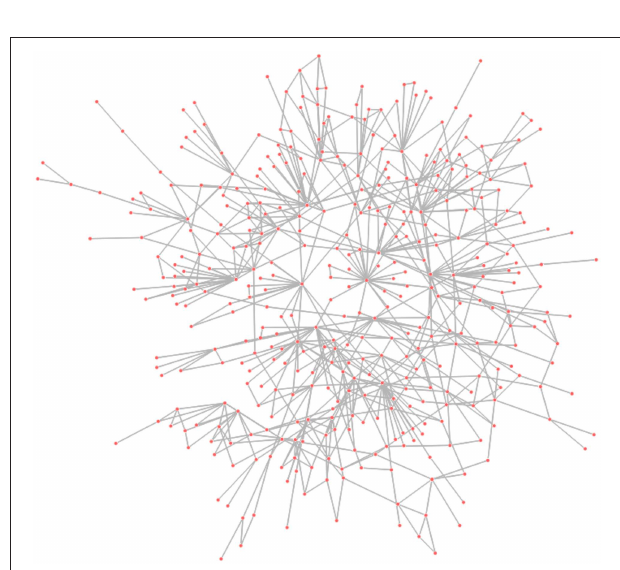
FIGURE 2 | Graph representation of the desert rose in Figure